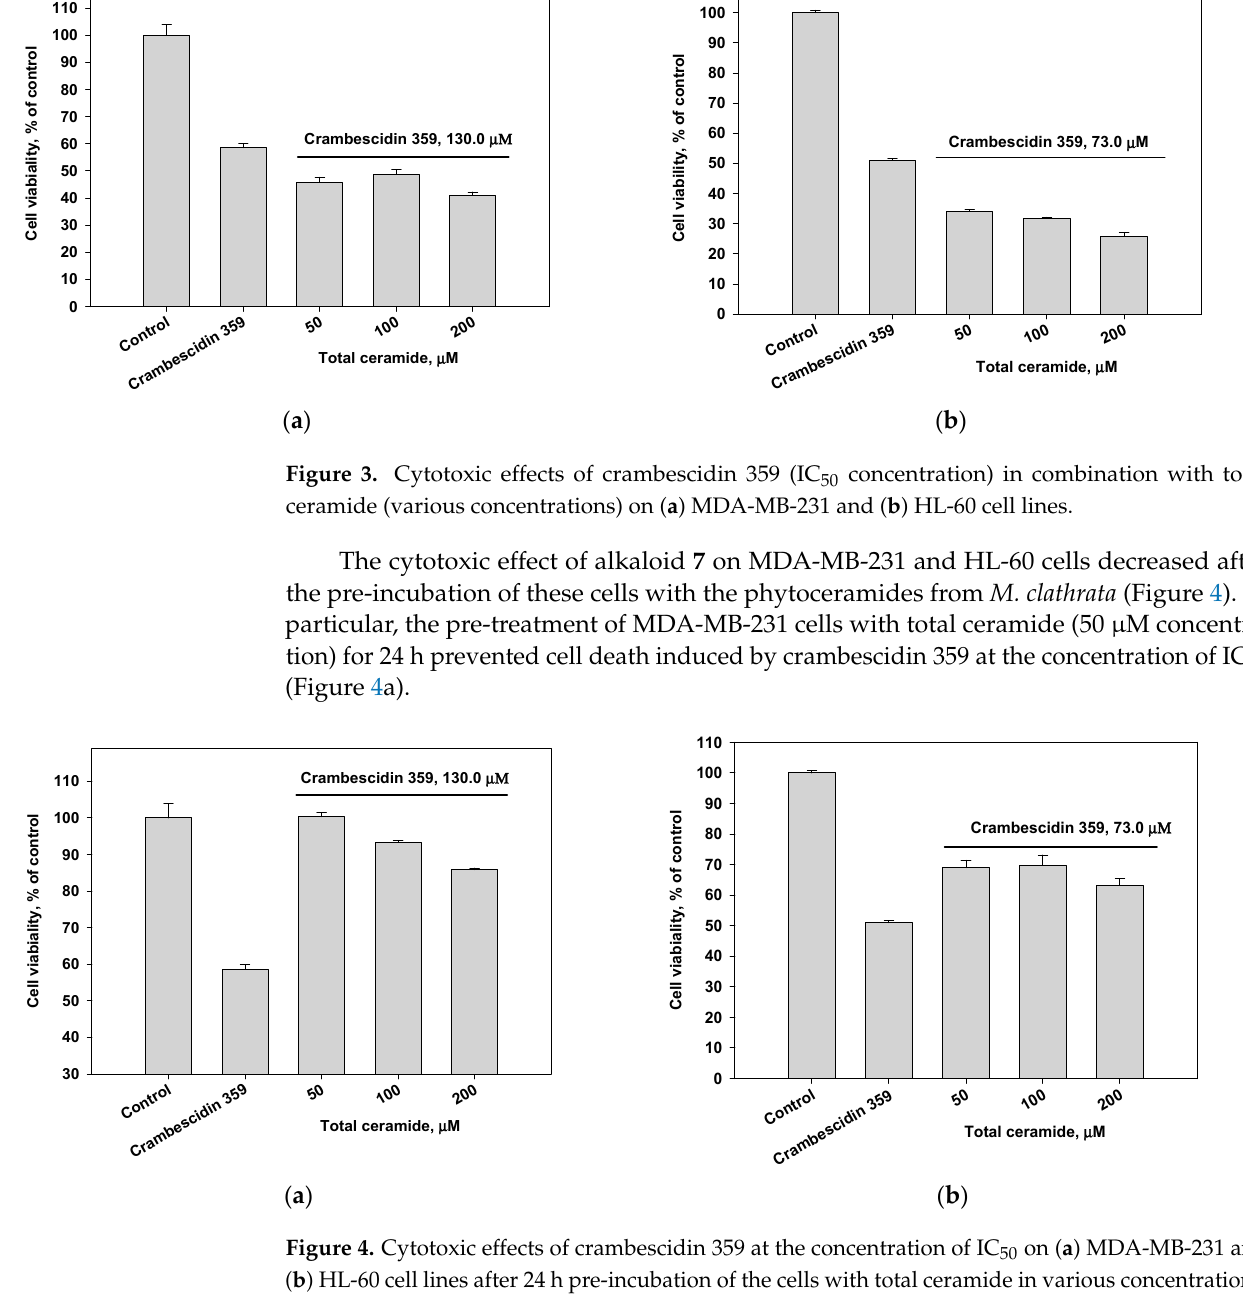
HL-60 cells was extremely weak (IC 50 values ≥ 200 µM, incubation for 48 h; Figure S11). Crambescidin 359 ( 7 ) exhibited weak cytotoxic activity against MDA-MB-231 (IC 50 130 µM) and HL-60 (IC 50 73 µM) cells (incubation for 24 h; Figure S12). Combinations of crambescidin 359 and total ceramide were slightly more cytotoxic for MDA-MB-231 cells (Figure 3a) and significantly inhibited the viability of HL-60 cells (Figure 3b).